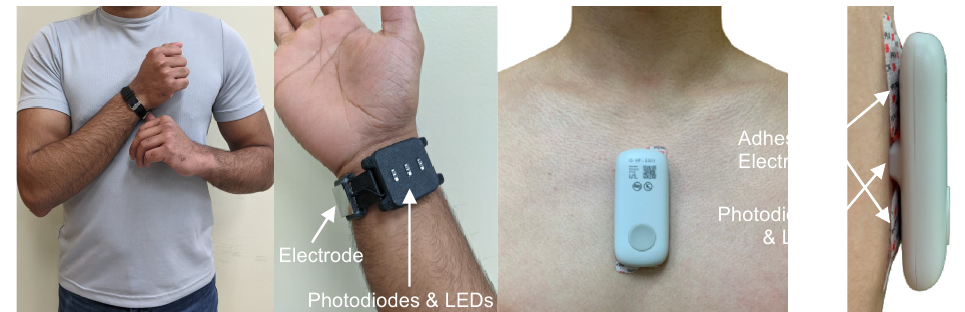
Figure 10. Device form factor. Electrodes for a single-lead ECG, photodiodes and LEDs to record the PPG, and tri-axial accelerometers and gyroscopes (internal to the devices) to acquire the SCG signal can be customized and modularized to work in multiple form factors. The left side shows the watch-based approach described in [60], while the right side shows an updated version of the chest-worn patch originally described in [59].